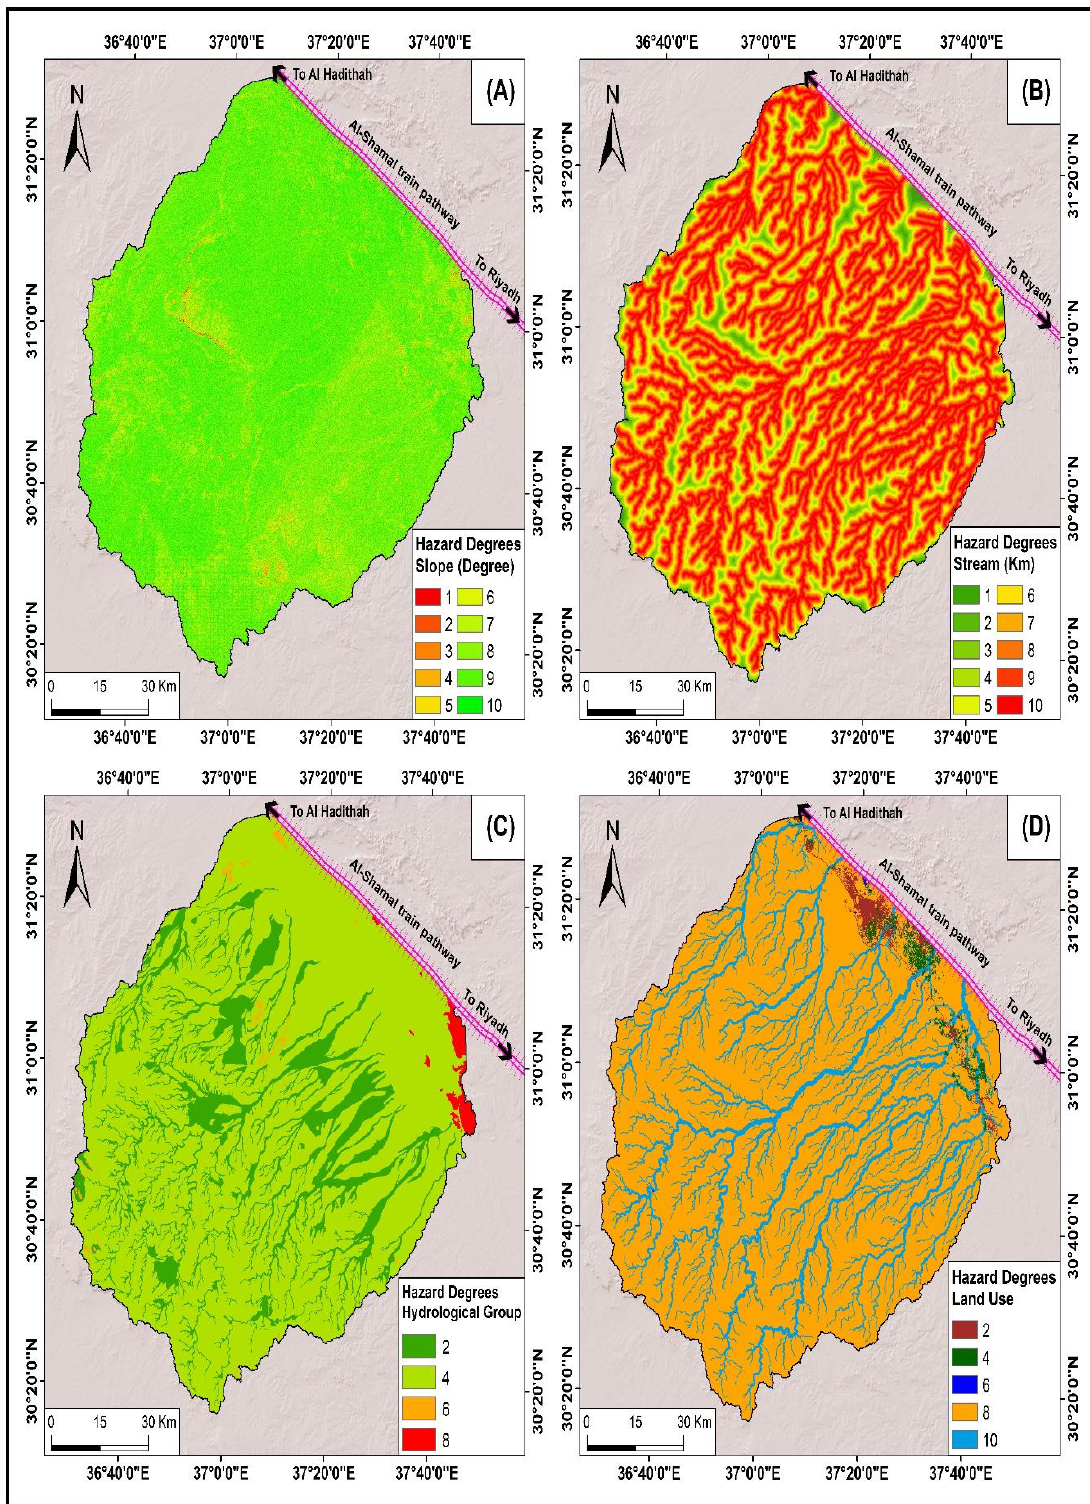
Figure 8. The degrees of hazard of the criteria a ff ecting the Al-Shamal train pathway in Qurayyat city in 2020: ( A ) slope; ( B ) distance to wadis; ( C ) hydrological soil groups; and ( D ) land cover.